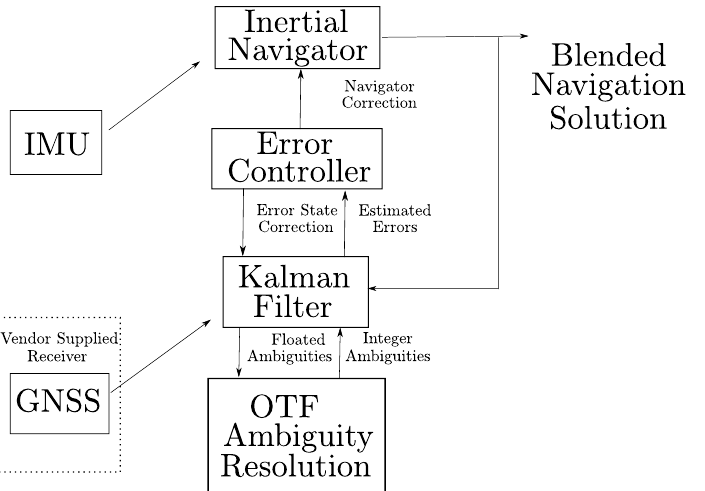
Figure 2. Block diagram of components within an integrated inertial system such as the Applanix POS LV-220